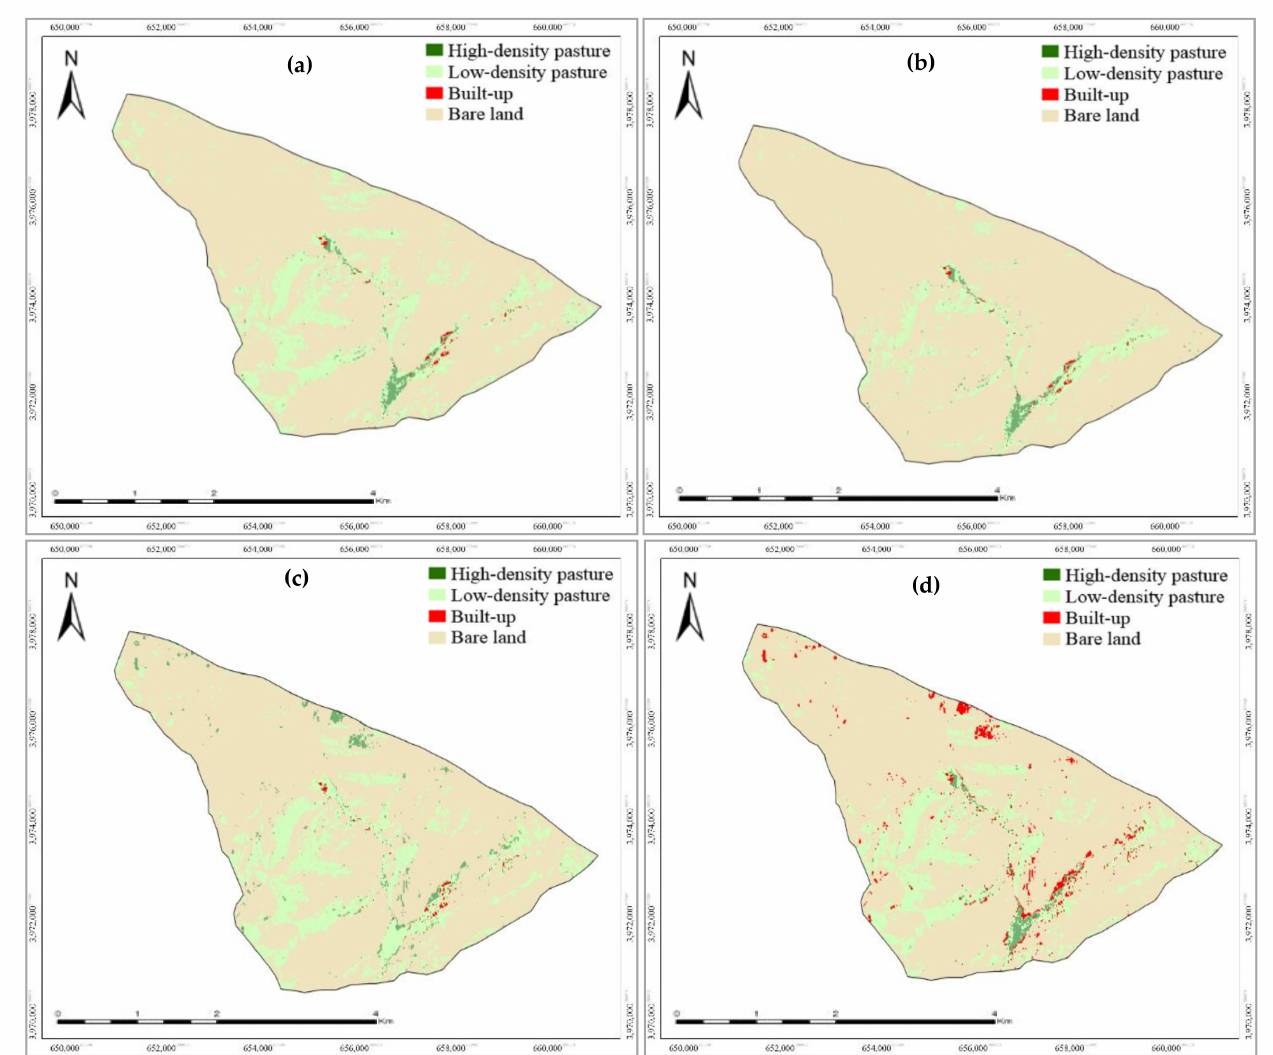
Figure 6. Temporal LULC maps in the TangehVashi; ( a ) 1989, ( b ) 1999, ( c ) 2009, ( d )